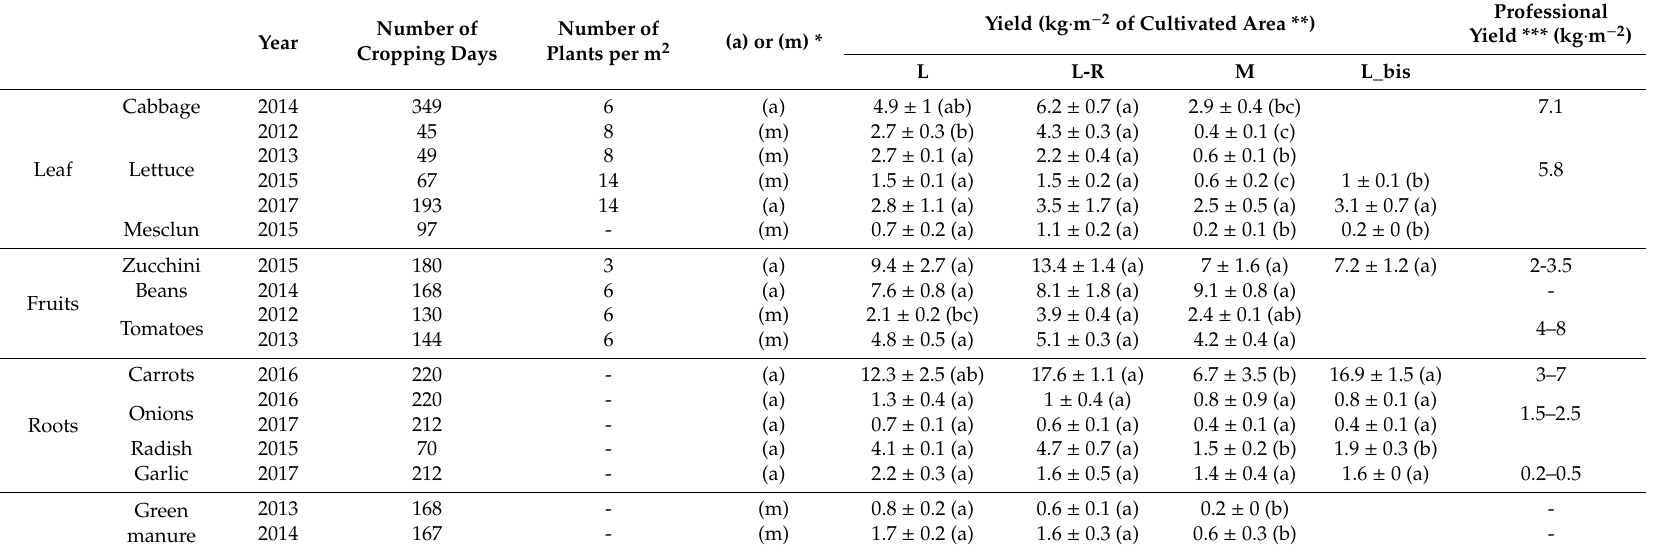
Table 3. Yield per year, per crop and per treatment. The letters correspond to statistical analysis per year allowing to compare di ff erent treatment ( p -value <